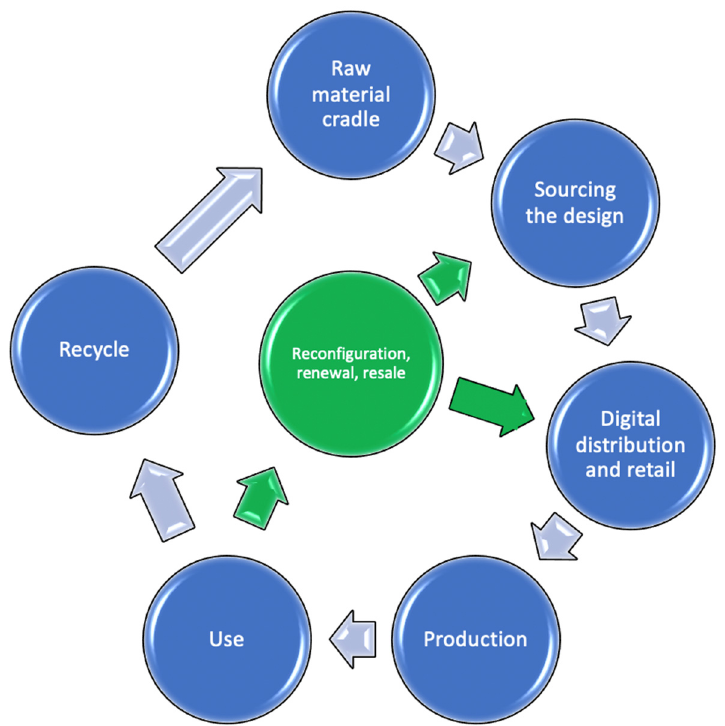
Figure 3. The proposed lifecycle of DDM-created clothing.